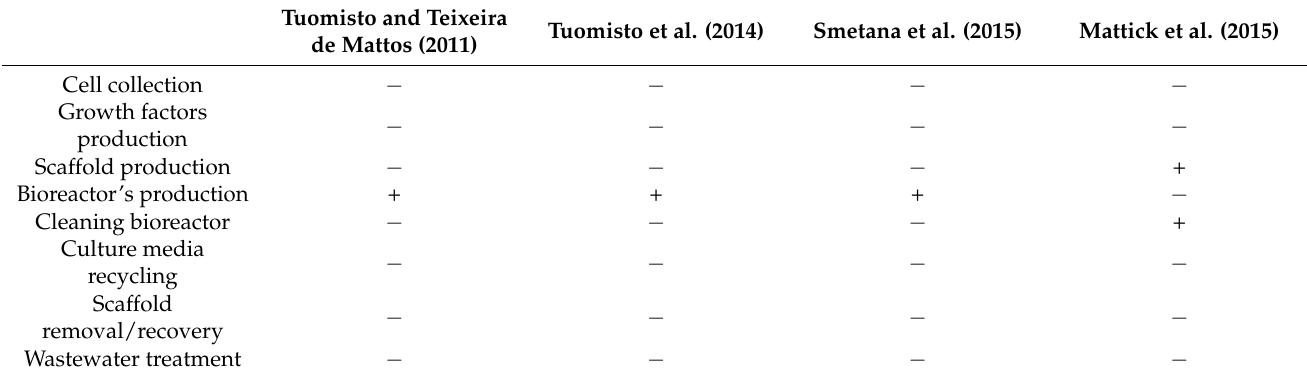
Table 2. Overview of materials and processes considered within or outside the scope of each study under analysis. Positive sign (+) indicates these processes or materials were included in their life-cycle inventories, while negative ( − ) sign indicates these were